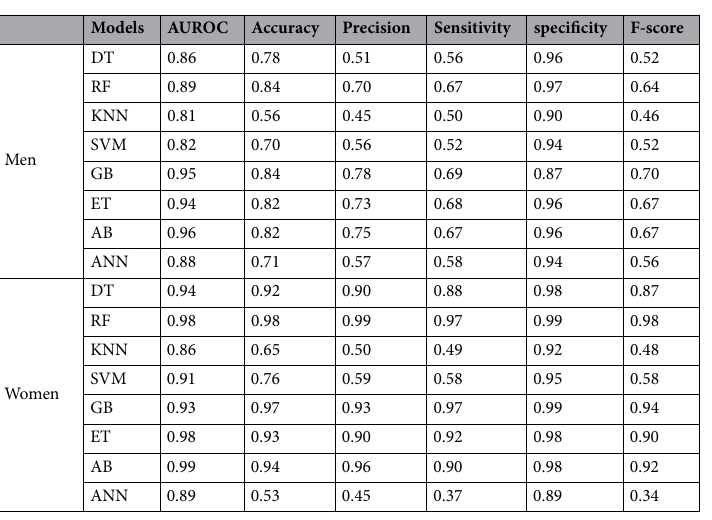
Table 7. Comparison of predictions of classification algorithms to recommend sports protocols between men and women groups.